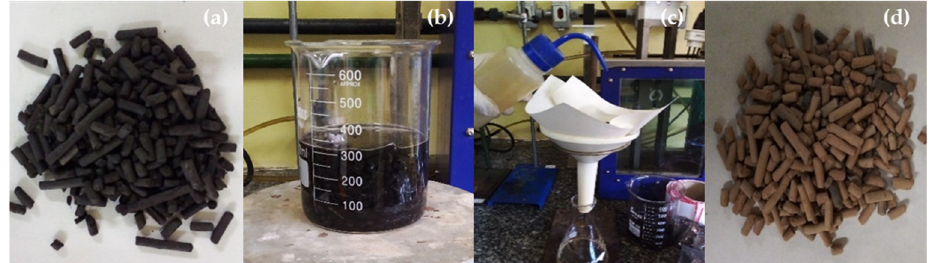
Figure 3. Activated carbon pellets impregnated with a 10.0 M NaOH solution (activated carbon pellets ( a ); wet impregnation ( b ); water washing ( c ); activated carbon pellets impregnated with NaOH ( d )).